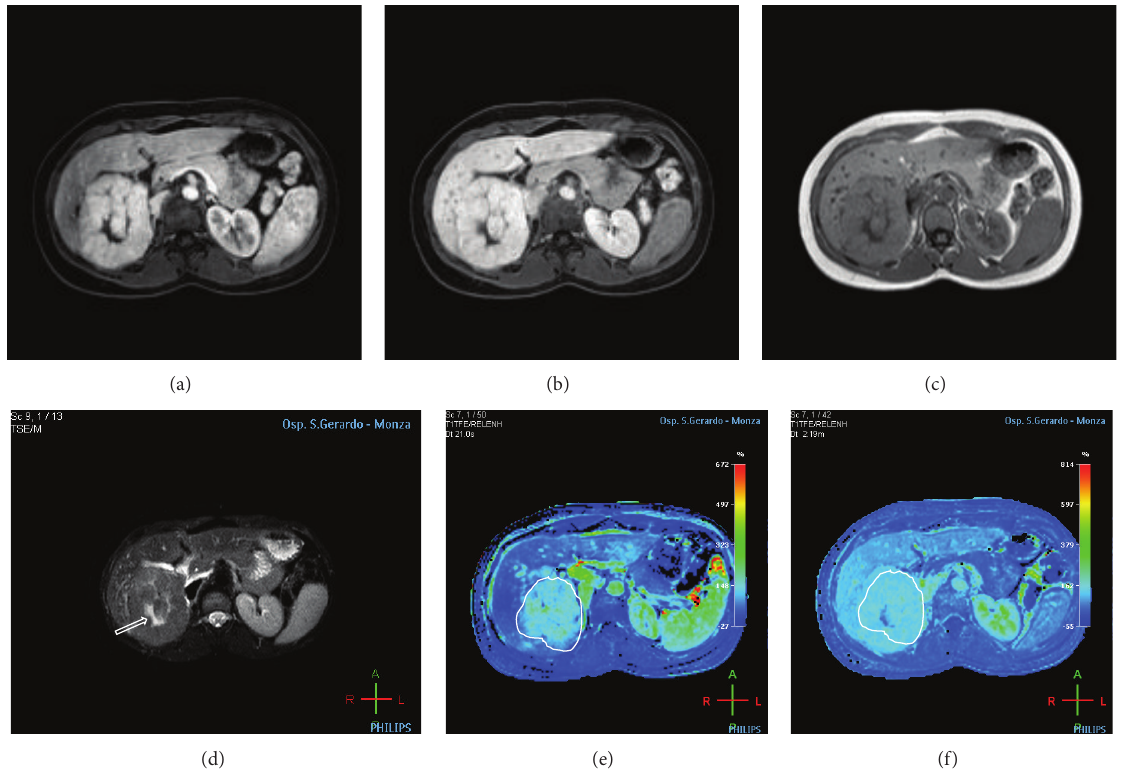
Figure 2: A 32-year-old woman with abdominal pain. The MR imaging shows a focal lesion in the right lobe. (a, b) Axial arterial and delayed postcontrast injection images; the lesion appears as a well-shaped hyperintense area in the arterial phase, with isointensity signal in delayed phase, with presence of hypointense central scar (arrow). (c) Axial T1-weighted in-phase echo-gradient sequence shows isointense irregular nodular area in the sixth segment. (d) Axial T2 fat-sat weighted sequence shows a rounded ill-defined nodular area, with slight intensity signal on T2-weighted images and with hyperintense scar (arrow) on the central part. (e, f) On colour perfusion maps (Relative Arterial Enhancement and Relative Late Enhancement, resp.) the lesion (ROI contouring the boundaries of the lesion) corresponds to hypervascular